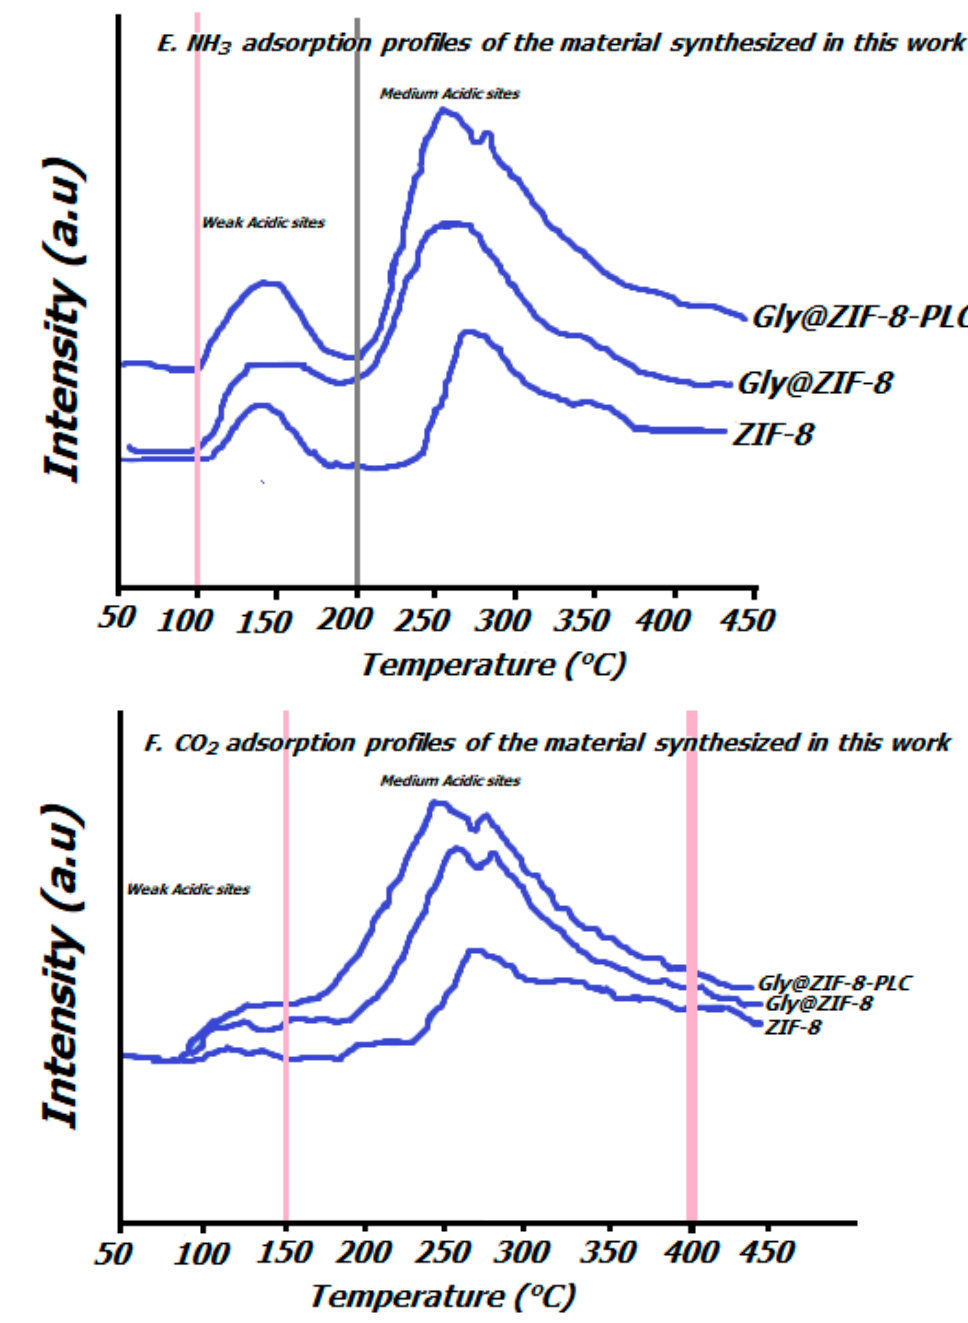
Figure 5. Raman spectrum: ( A ) ZIF-8, ( B ) Gly@ZIF-8, ( C ) ZIF-8-PCL, ( D ) Gly@ZIF-8-PCL, and ( E ) NH 3 adsorption profiles of the material synthesized in this work. ( F ) CO 2 adsorption profiles of the material synthesized in this work.